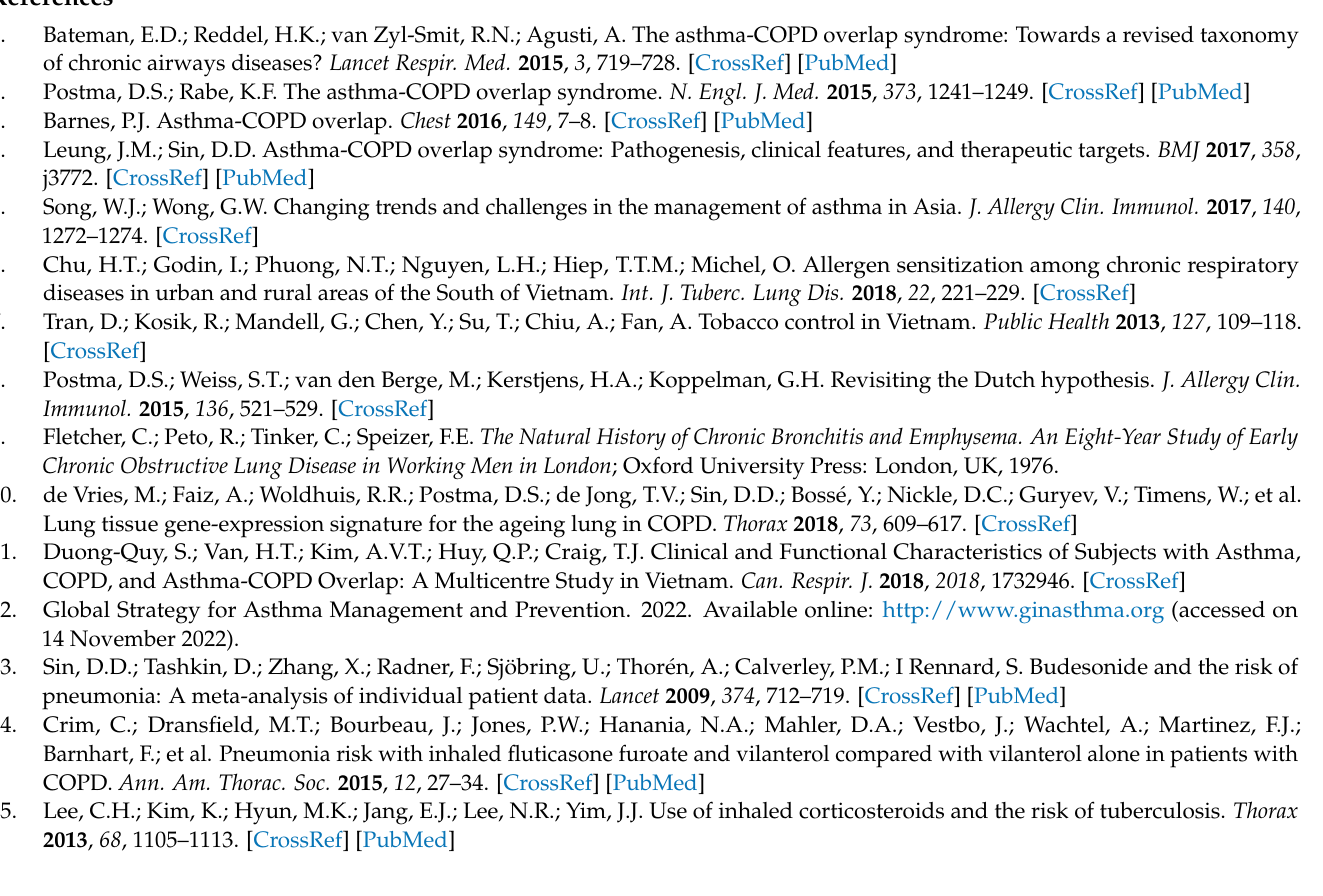
Figure A2. The relationship between age group and the prevalence of each phenotype of obstructive airway diseases, based on bronchial reversibility defined as a >10% change of FEV1 predicted value. Patients were defined as ( A ) COPD, ( C ) asthma or ( B ) ACO in regard to a positive, negative or non-significant relationship with aging. ( D ): the age-related relative prevalence of ACO-like COPD (pink bar) with a DLCO < 80% PV. ( E ): the age-related relative prevalence of ACO-like asthma (light orange bar) with a DLCO ≥ 80% PV. COPD: chronic obstructive pulmonary disease. ACO: asthma — COPD overlap.